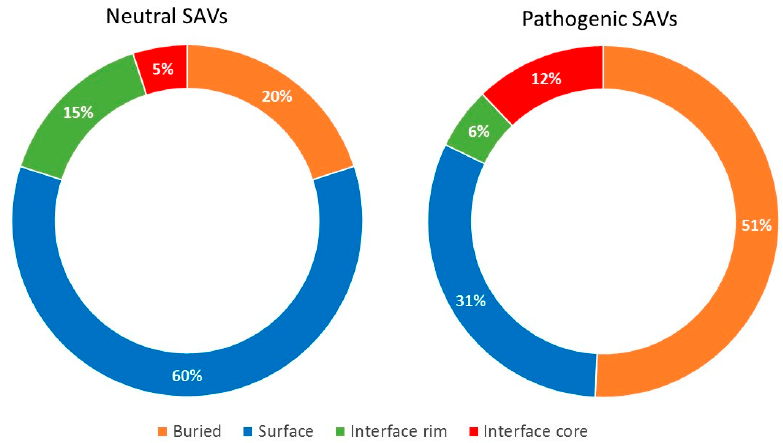
Figure 2. Structural characterization of residues in HBB affected by neutral or pathogenic variants.